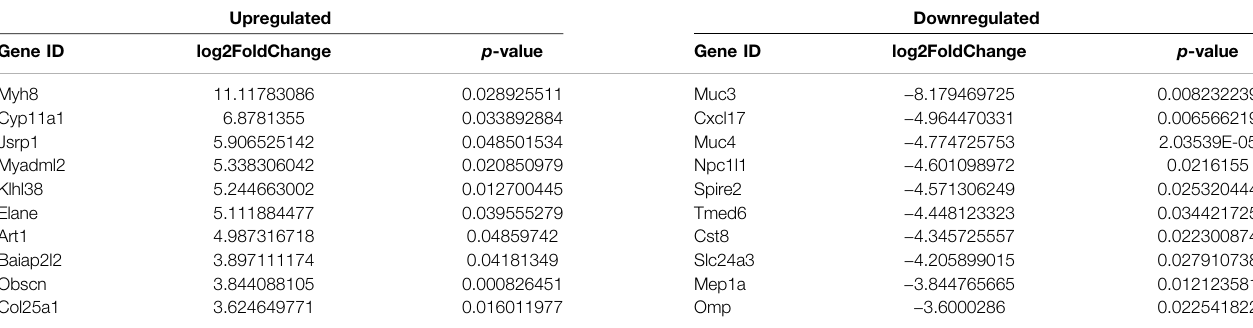
TABLE 1 | Top10 of DEGs between KOT and NCT